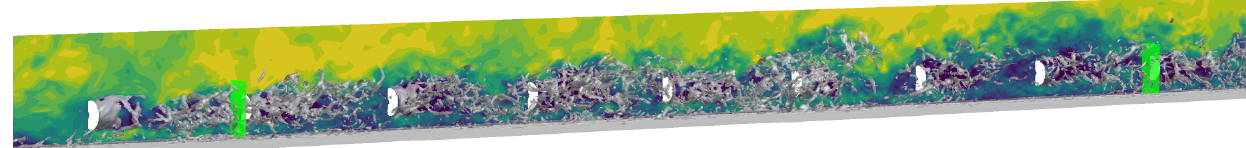
Figure 3. Vertical plane of streamwise velocity as well as iso-surface of the vorticity through a wind farm. Turbines are marked in white circles, and planes for extracting inflow velocity components for WT02 and WT09 are shown in green.